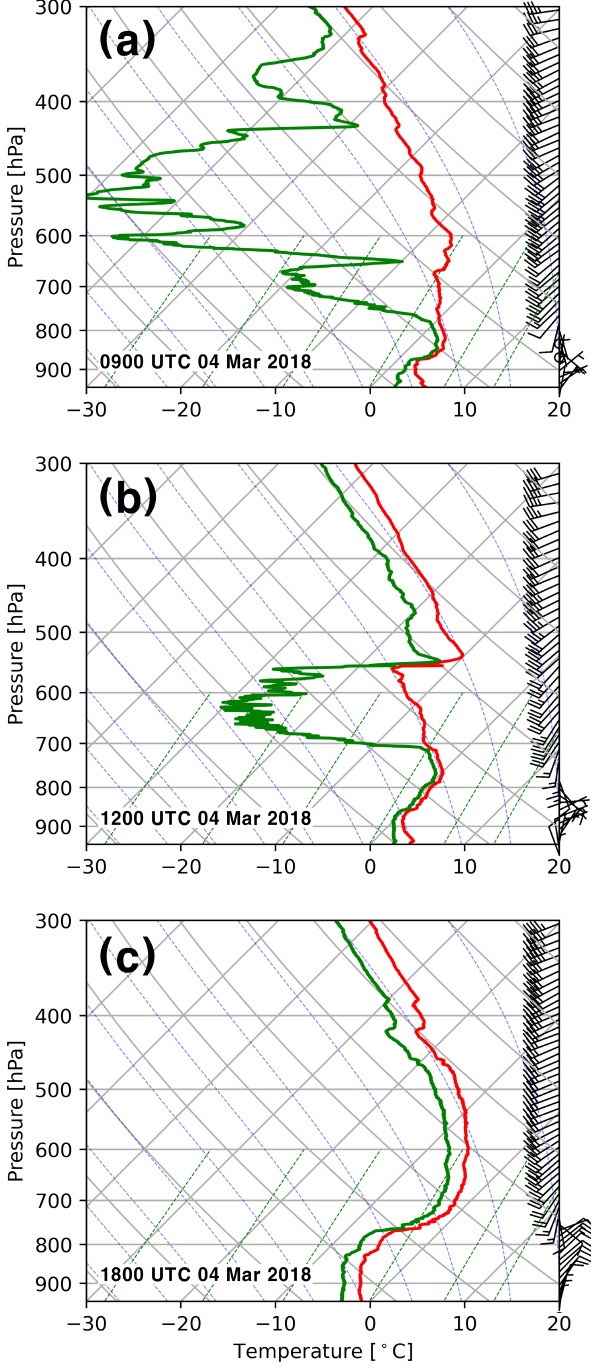
Figure 3. Skew T -log p diagrams for (a) 09:00UTC, (b) 12:00UTC, and (c) 18:00UTC of a warm-low event (4 March 2018) at the Daegwallyeong weather office (DGW; mountainous area). The skew T -log p chart was created using the MetPy package (May et al., 2008–2021) in Python. The red (green) solid line represents the temperature (dew point